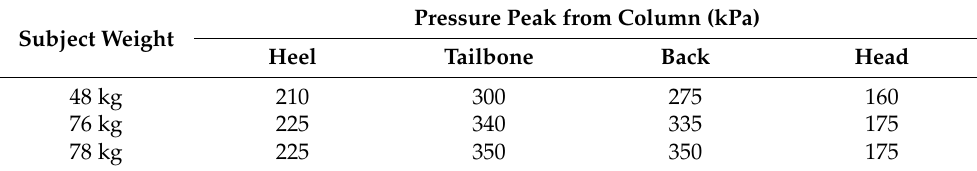
Table 1. pressure between people of different weights.